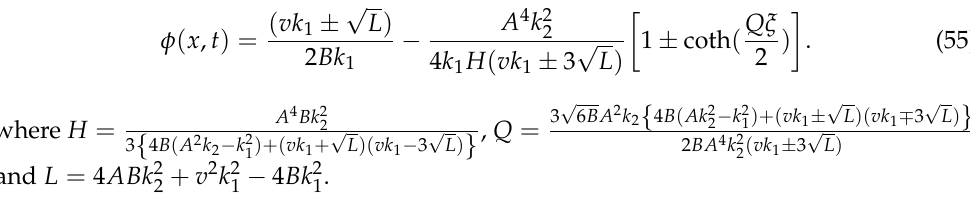
Figure 2. ( a – c ) Present imaginary part of solitonic wave ),( tx =−==== tghk γ ric situations .2,2,1,5.0,5.0 shape in contour; ( c ) Complex shape in 2D.